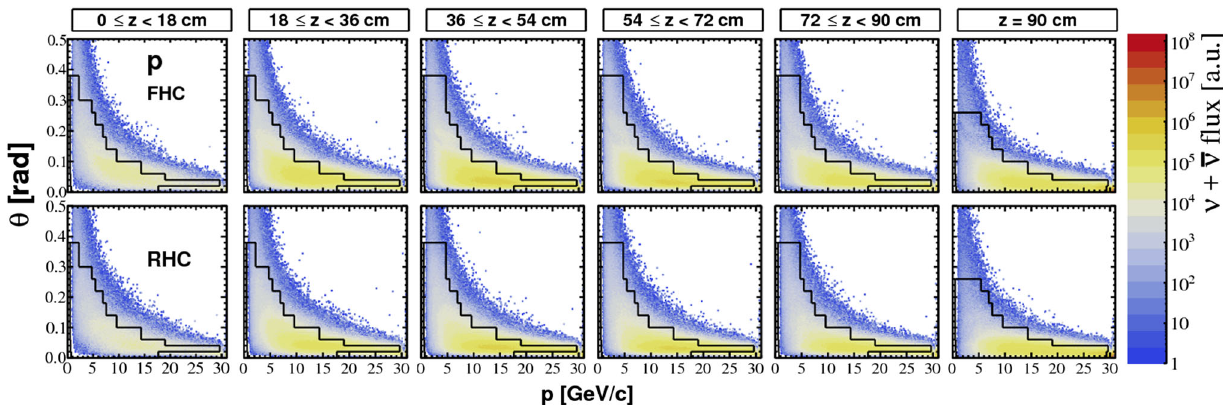
horn current configuration, while bottom plots show the phase space for the reverse horn current configuration. The NA61/SHINE coverage from the 2010 replica target measurement is overlaid on top of the plots d E / d